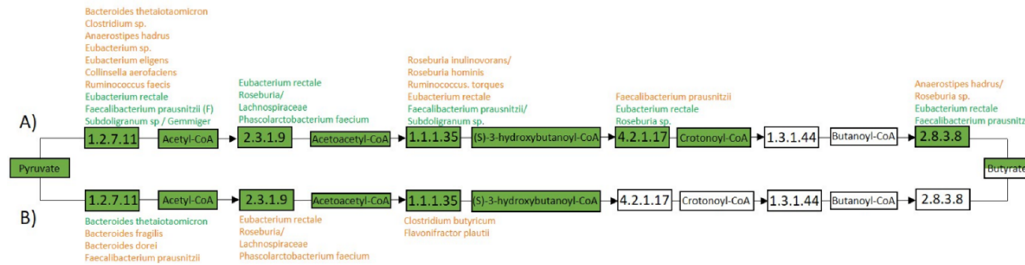
Figure 7. Protein presence related to butyrate production. The figure gives an overview of bacterial proteins (E.C. number) in relation to the butyrate pathway butyryl-CoA:Acetate CoA-transferase. The figure shows proteins detected (green box) in infants with the E. rectale network ( A ), or R. gnavus network ( B ). Bacterial taxonomy is shown next to each E.C. number, representing the bacterial source of the given protein. The bacterial sources are divided by two different colors, where orange represents detection in three or fewer samples in ( A ) or two or fewer in ( B ), and green represents detection in four or more in ( A ) or three or more in ( B ).